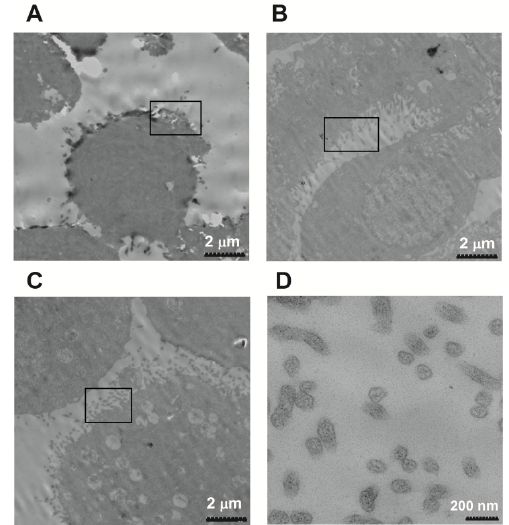
Figure 4. Electron microscopy images of increased exosome release from Hela cells after the stimulation with a calcium ionophore. ( A ) Hela cells without A23187 stimulation; ( B ) Hela cells stimulated with 0.5 μ mol/L of A23187; ( C , D ) Hela cells stimulated with 1 μ mol/L of